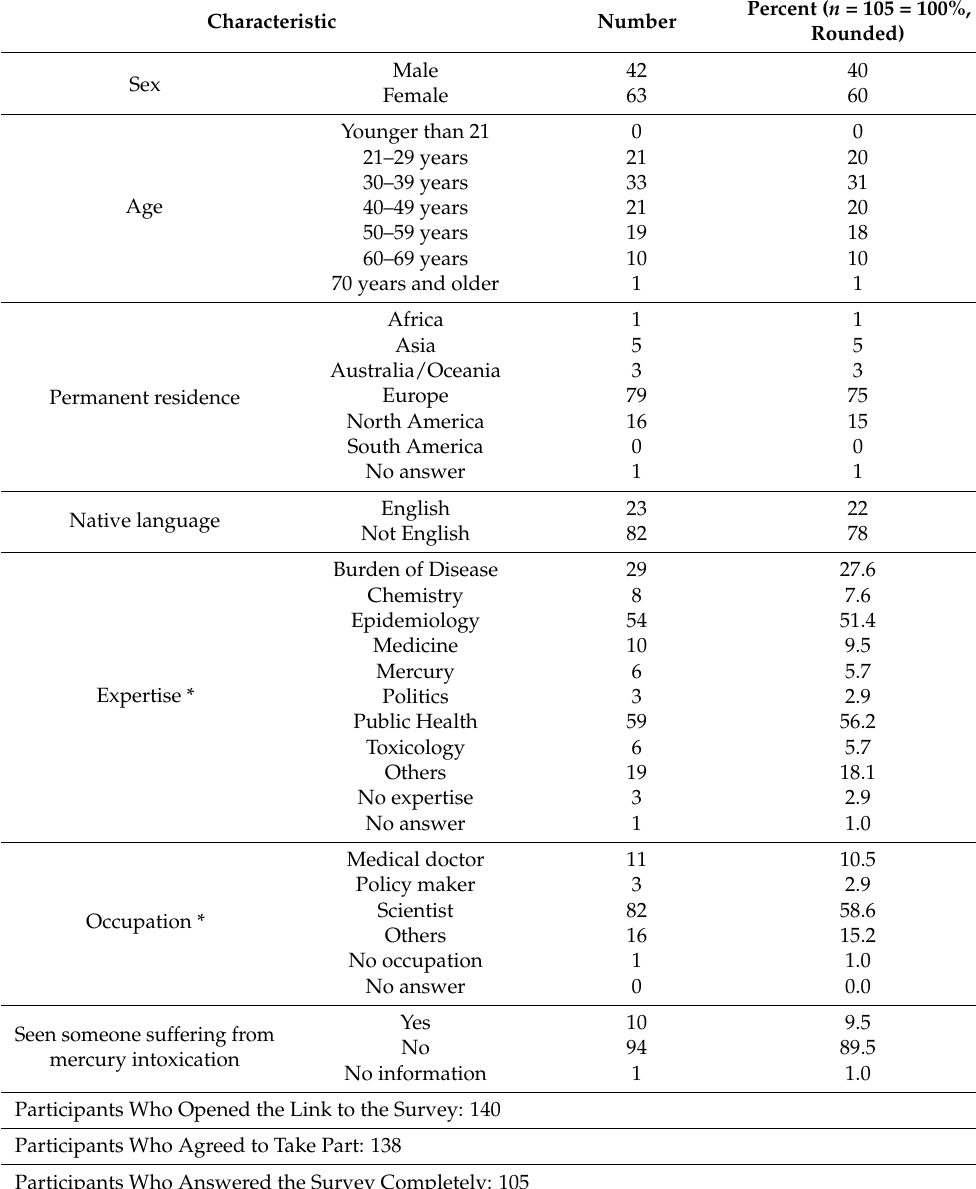
Table 3. Sociodemographic characteristics of the